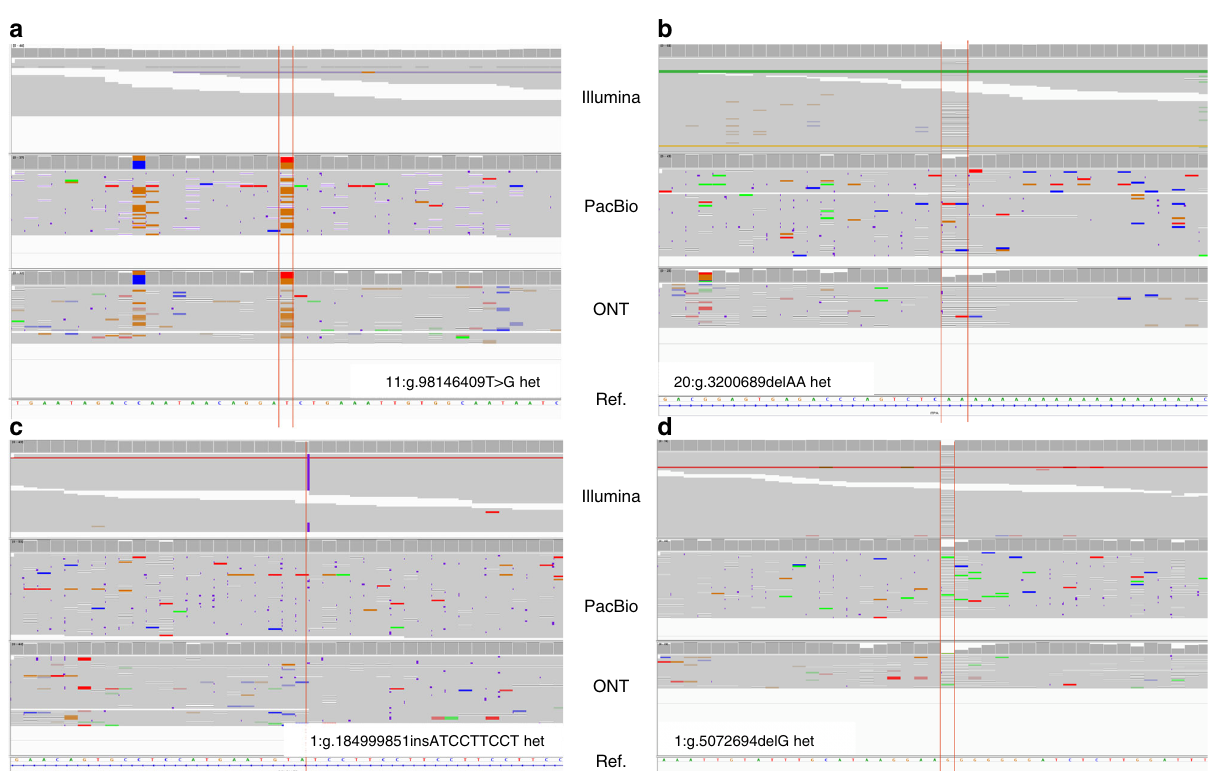
Fig. 1 The IGV screen capture of the selected variants. a A heterozygote SNP from T to G at chromosome 11, position 98,146,409 called only in the PacBio and ONT data, b a heterozygote deletion AA at chromosome 20, position 3,200,689 not called in all three technologies, c a heterozygote insertion ATCCTTCCT at chromosome 1, position 184,999,851 called only in the Illumina data, and d a heterozygote deletion G at chromosome 1, position 5,072,694 called in all three technologies. The tracks from top to down show the alignments of the Illumina, PacBio, and ONT reads from HG001 aligned to the